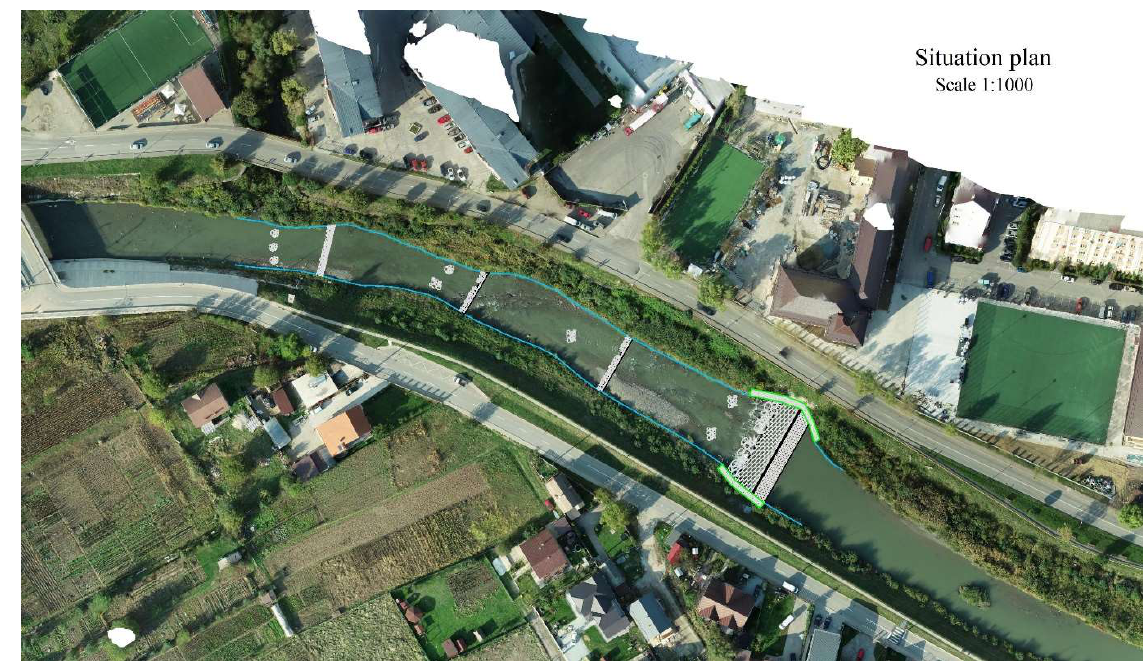
Figure 5. Graphical representation of the identified alternative method.